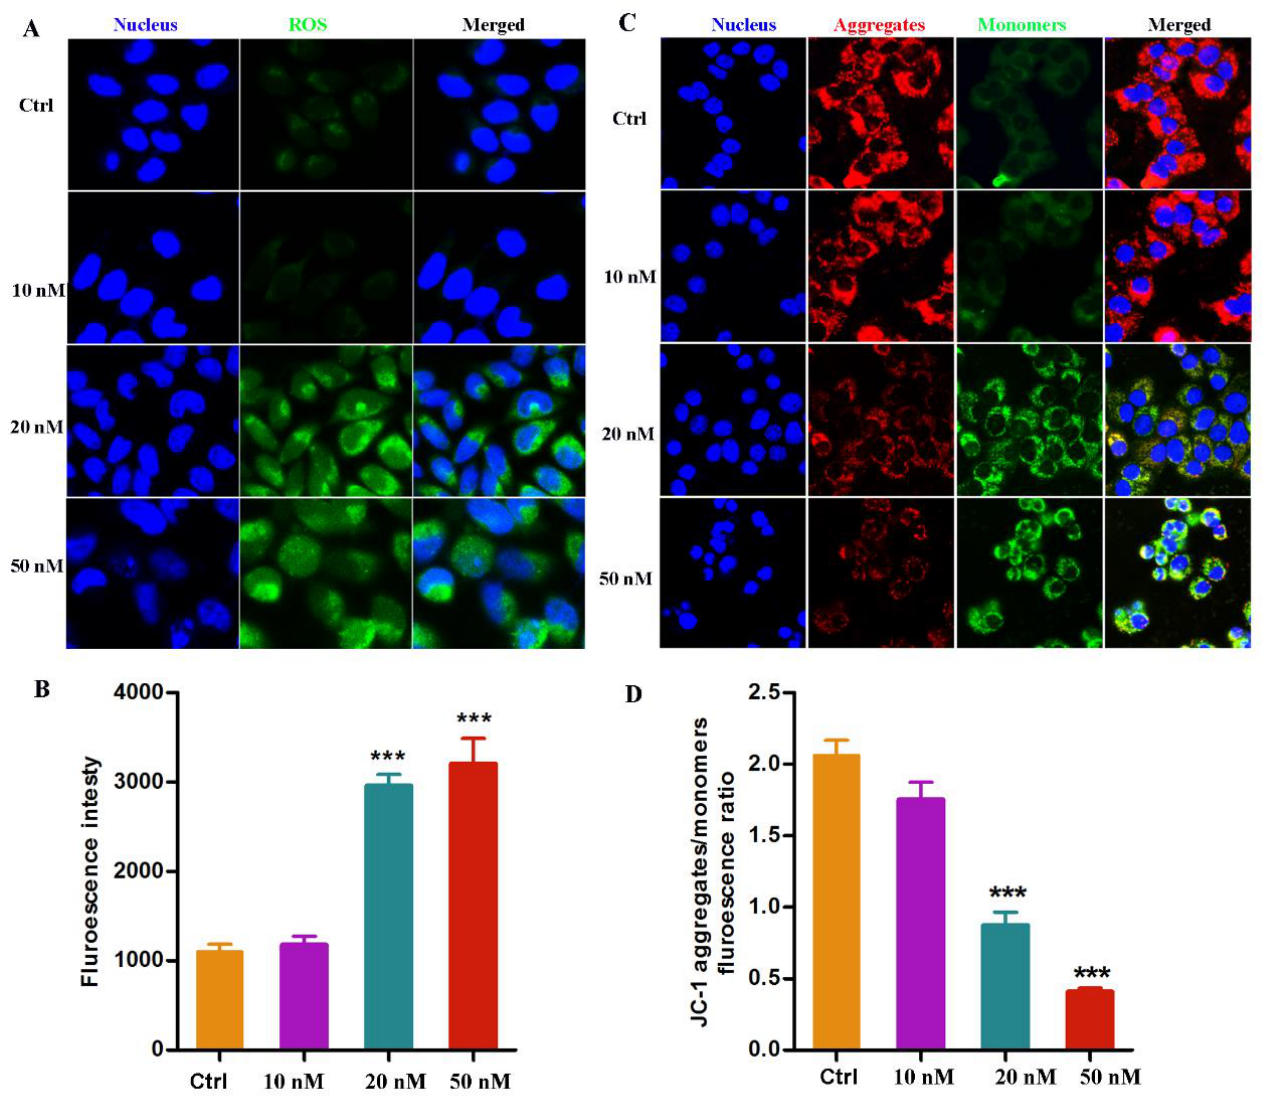
Figure 5. ROS accumulation and MMP alteration induced by compound 14b . ( A , B ) The intracellular ROS detection by DCFH-DA after A549 cells treated with compound 14b at indicated concentrations for 12 h. ( C , D ) The detection of MMP monitored by JC-1 dye after A549 cells treated with compound 14b at the concentrations of 10, 20 and 50 nM for 12 h. The experiments were performed at least three times, and the results of the representative experiments are shown. Data are presented as mean ± SEM *** p < 0.001 vs. Control group; significant difference as compared with the control group by t test. Scar bar: 10 μm .